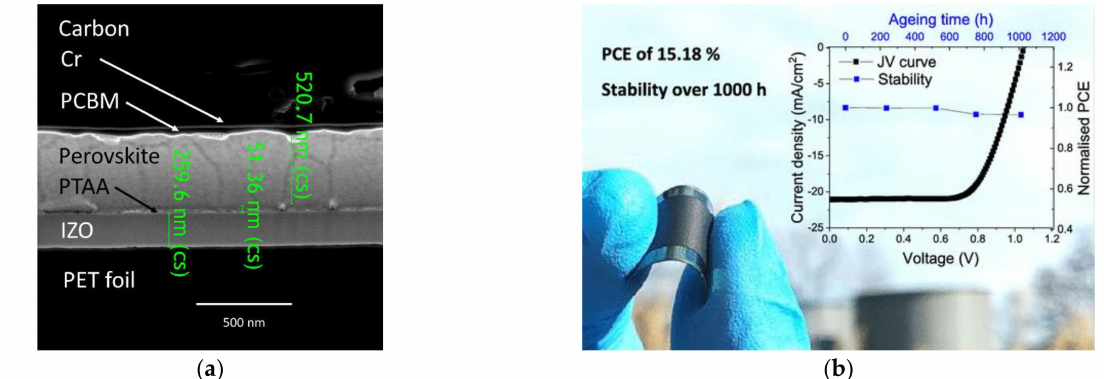
Figure 6. ( a ) A cross-section SEM image of a carbon electrode-based perovskite solar cell on a PET foil. ( b ) A photograph image of the carbon electrode-based flexible perovskite solar cell with (i) a photocatalytic current density and voltage curve and (ii) thermal (85 ◦ C) stability of the device over 1000 h of aging. Reprinted from Vivek Babu et al., (2020), [74] Copyright (2020), with permission from The American Chemical Society (further permissions related to the material excerpted should be directed to The American Chemical